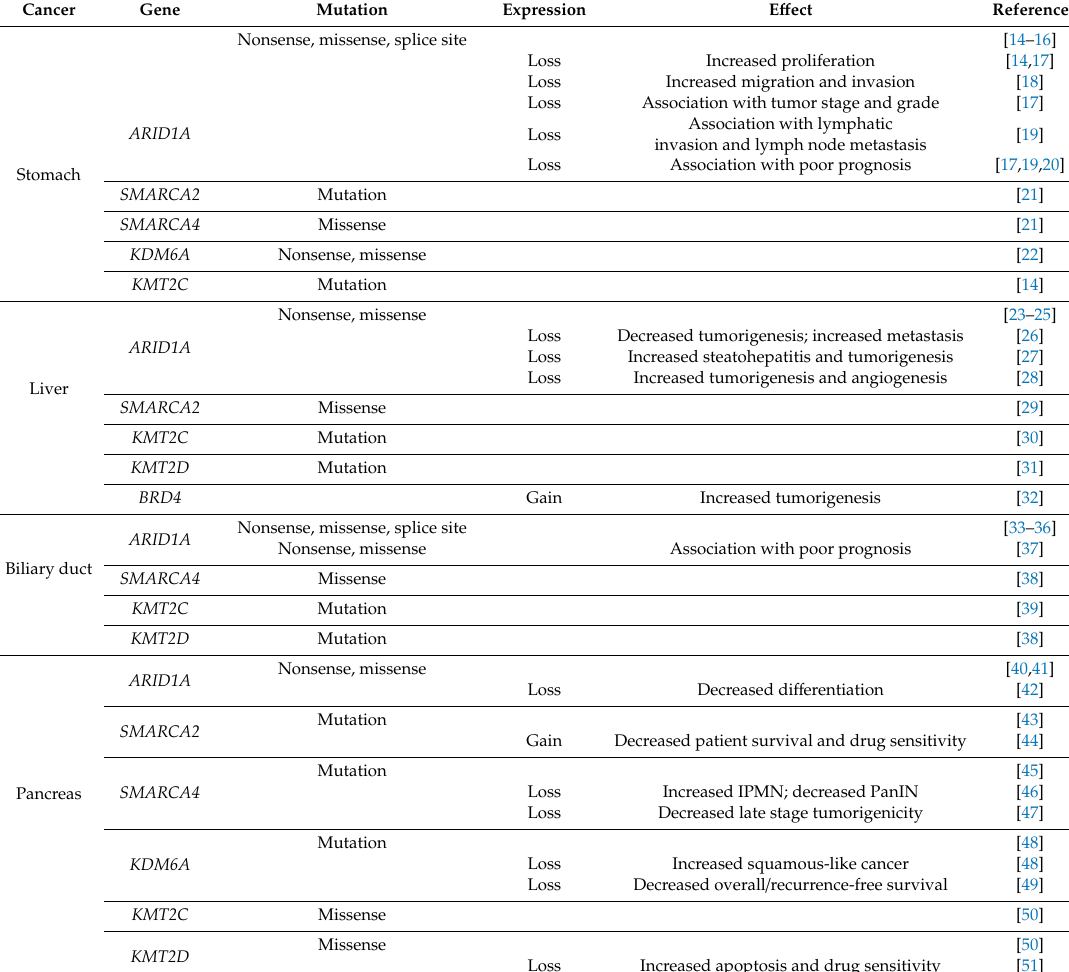
Table 2. ARID1A , SMARCA2 , SMARCA4 , KDM6A , KMT2C , KMT2D , and BRD4 mutation status in cancers of the stomach, liver, biliary duct, pancreas, and